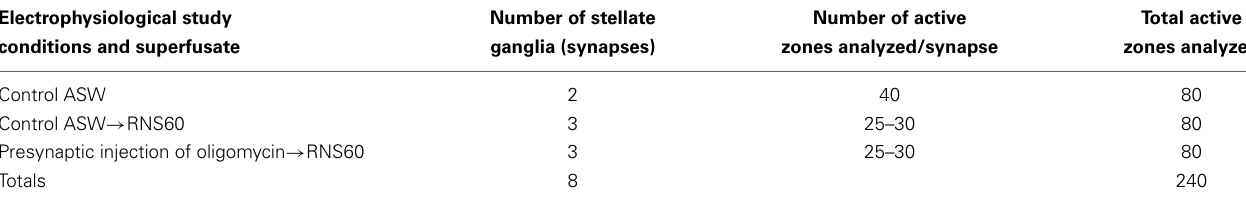
Table 1 | Number of synapses and active zones used in the ultrastructural analysis. Electrophysiological